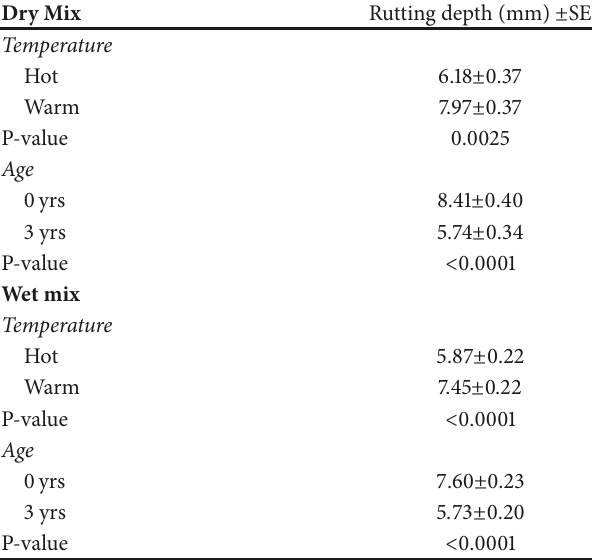
Table 5: Least squares means and standard errors for age and temperature levels for the dry mix condition and for the wet mix